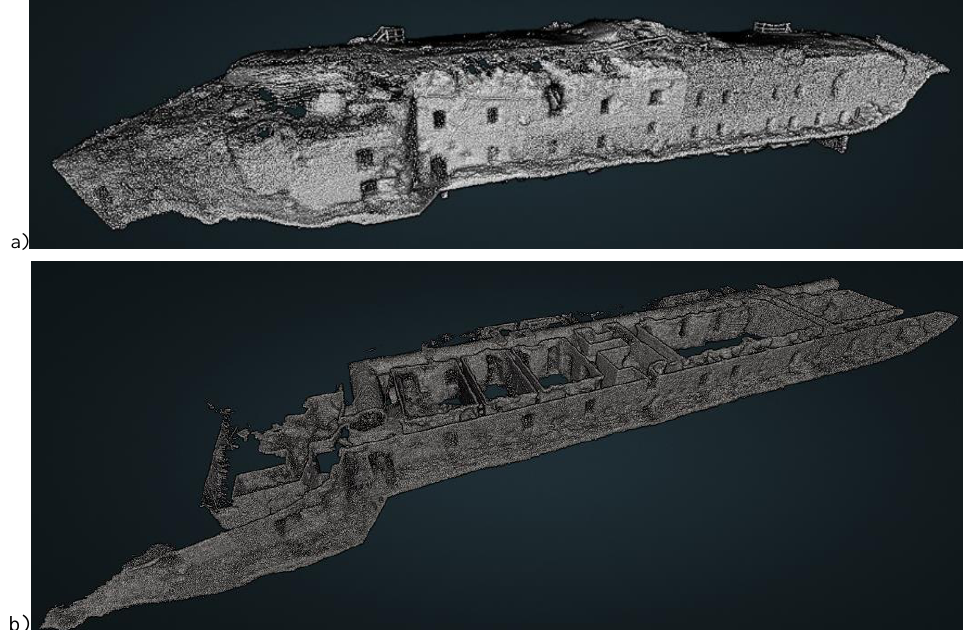
Figure 9. Point clouds of the exterior (a) and ground floor (b) of Sommo Alto